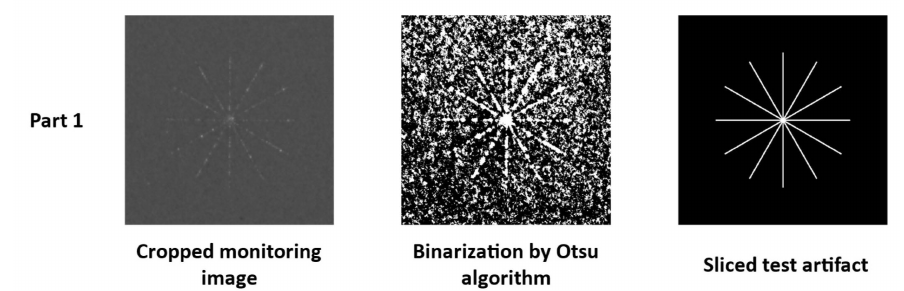
Figure 7. Binarization failure of part 1 with 200 µ m line width.